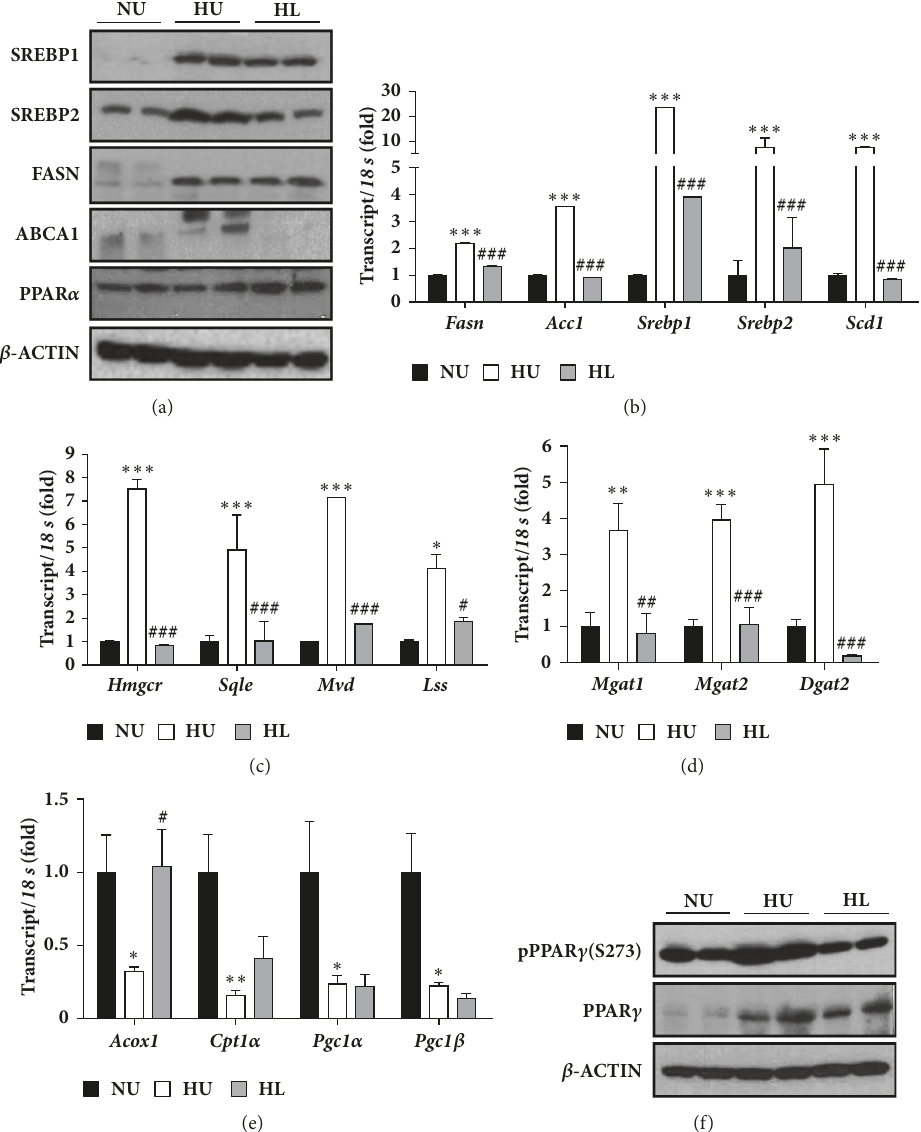
Figure 4: Lobeglitazone regulates hepatic lipid metabolism in HFD-fed mice. (a) Protein expression of lipid metabolism-related genes in liver tissues. ß-actin was included as a loading control. (b) Expression levels of de novo lipogenesis-related genes in liver tissues. (c) Expression levels of cholesterol biosynthesis-related genes in liver tissues. (d) Expression levels of lipid droplet development-related genes in liver tissues. (e) Expression levels of fatty acid 𝛽 -oxidation related genes in liver tissues. (f) Protein expression of pPPAR 𝛾 (S273) and PPAR 𝛾 in liver tissues. ß-ACTIN was included as a loading control. NU: normal chow diet- (NCD-) fed mice without treatment (NU, black bar), HU: HFD-fed mice without treatment (white bar), and HL: HFD-fed mice with lobeglitazone treatment (gray bar). Data are expressed as means ± SEM. ∗ p < 0.05, ∗∗ p < 0.001, and ∗∗∗ p < 0.0001, NU versus. HU group. # p < 0.05, ## p < 0.001, and ### p < 0.0001, HU versus. HL